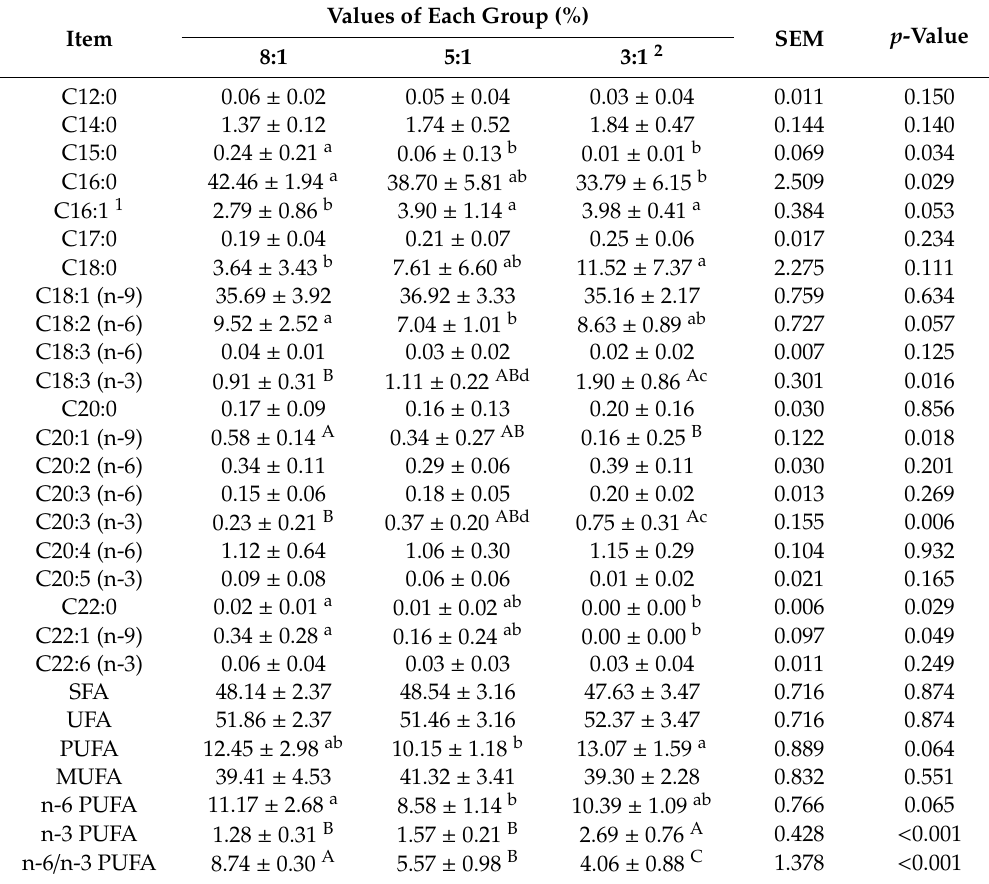
Table 5. Fatty acid profiles in LDM of Heigai pigs fed with di ff erent